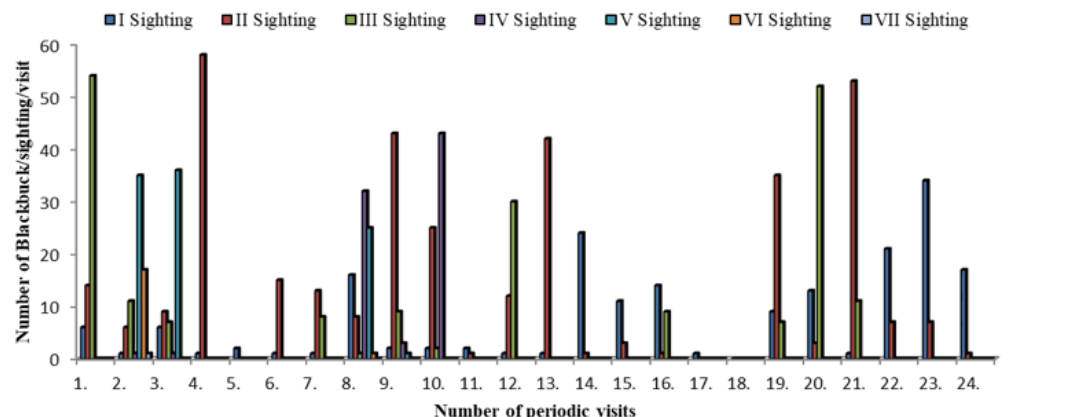
Figure 2. Number of Blackbuck sightings/visit and number of individuals/sighting in and around Lalpur Jheel, Dobhi Village during March 2017 to February 2018.